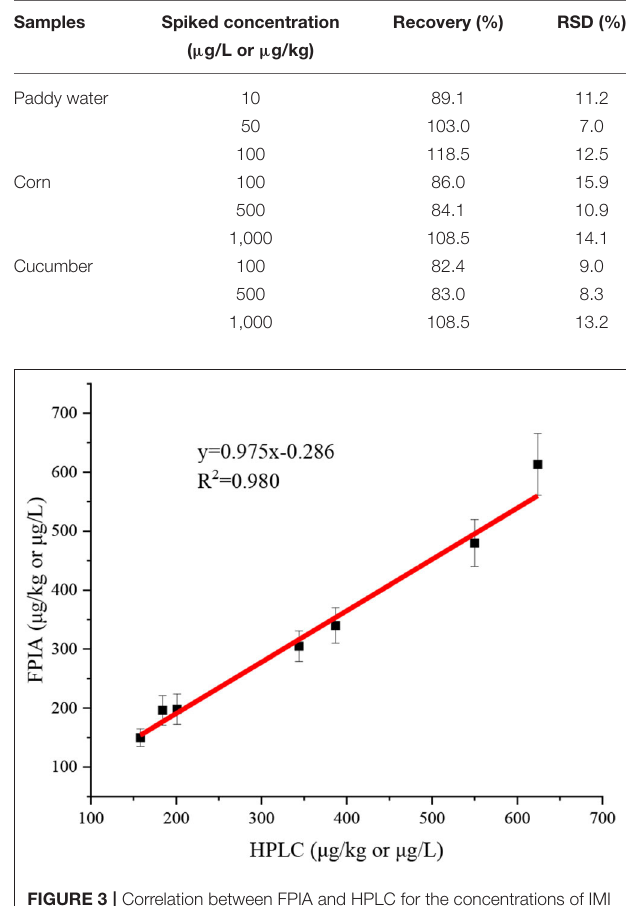
TABLE 4 | Recovery of IMI in spiked samples.